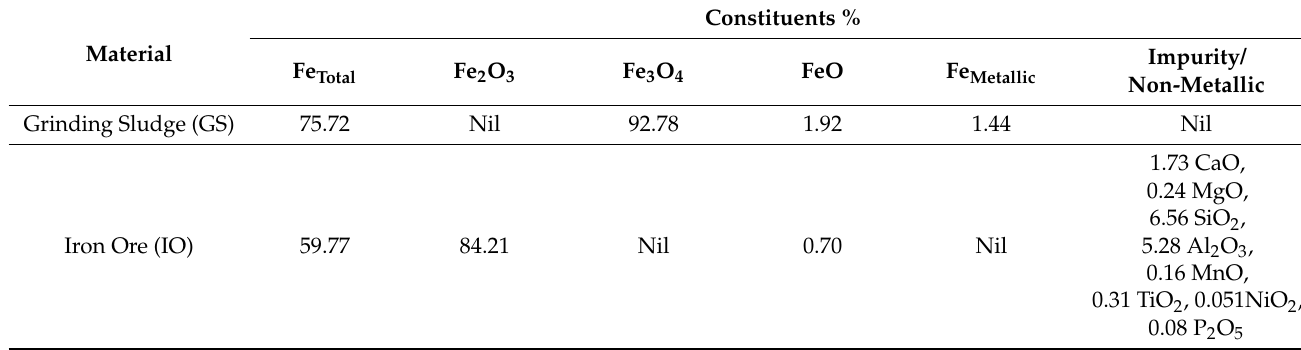
Figure 1. Scanning electron micrographs of ( a ) grinding-sludge powder and ( b ) iron-ore powder. Table 1. Phase distribution in iron oxide source material. Table 1. Phase distribution in iron oxide source material.